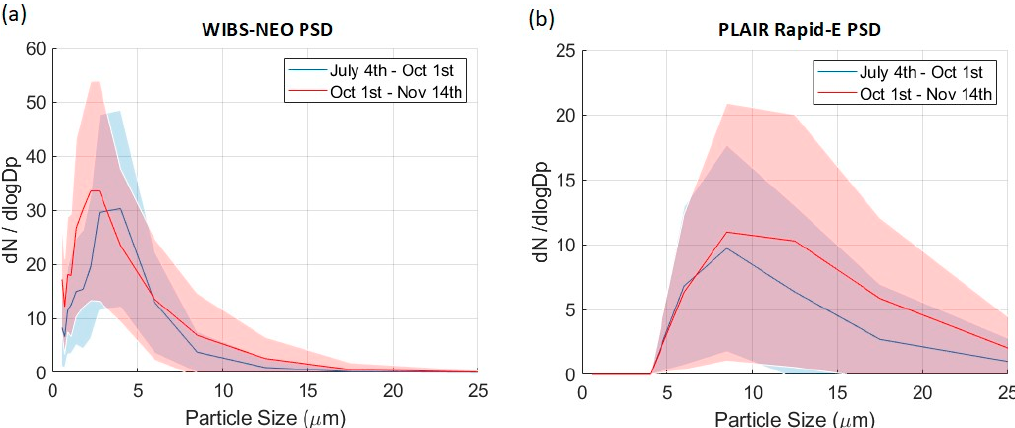
Figure 3. Biofluorescent particle size distribution (dN / dlogDp (L − 1 ) for the WIBS-NEO ( a ) and PLAIR Rapid-E ( b ) for two periods (see text). Blue line—average for the period of 4th July–1st October; red line—average for the period 1st October–14th November. x -axis values represent the average size of the bins used. Shaded areas represent ± 1 standard deviation.